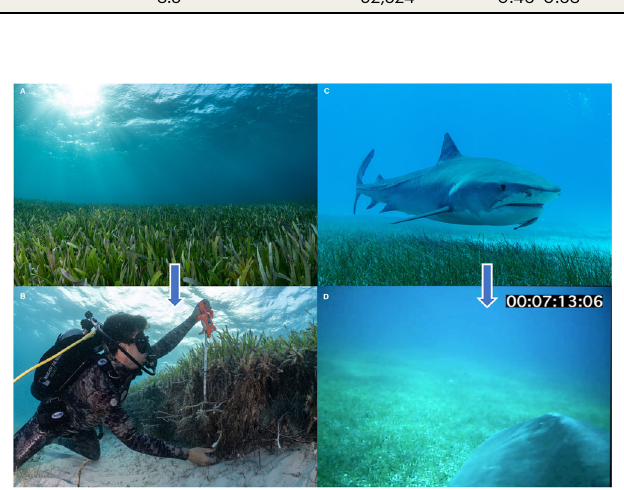
Fig. 2 | Seagrass meadows on The Bahamas Banks, assurveyedby humans and tiger sharks. A , B Dense meadow of Thalassia testudinum photographed in the southernGreatBahama Bank showing natural erosion scarp exposing the ~1 meter thick root rhizosphere (both images credit: Cristina Mittermeier). C Mature tiger shark swimming over Syringodium fi liforme on the Little Bahama Bank (image credit: AustinGallagher). D POV from camera-mounted tiger shark swimming over dense area of Thalassia testudinum on the northern Great Bahama Bank (image credit: Tiger Shark from